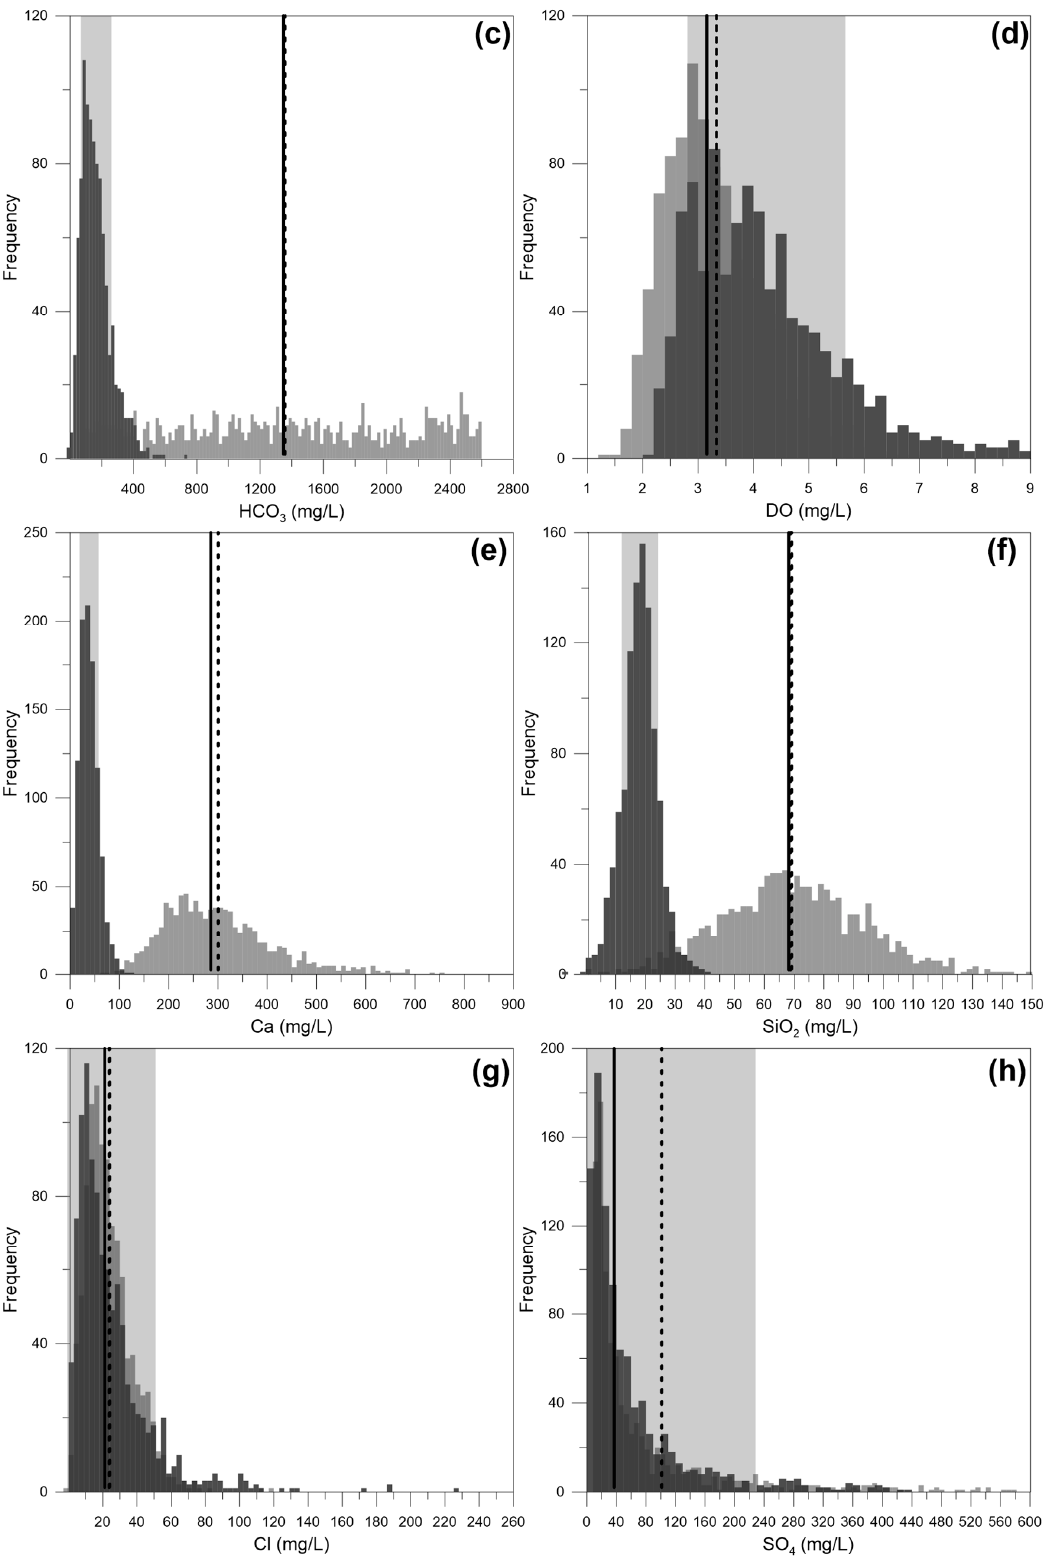
Figure 3. Probability density distributions of major parameters of CO 2 -rich (gray) and ordinary (dark gray) groundwaters in Gyeongsang Province. ( a ) EC, ( b ) TDS, ( c ), HCO 3 , ( d ) DO, ( e ) Ca, ( f ) SiO 2 , ( g ) Cl, ( h ) SO 4 .